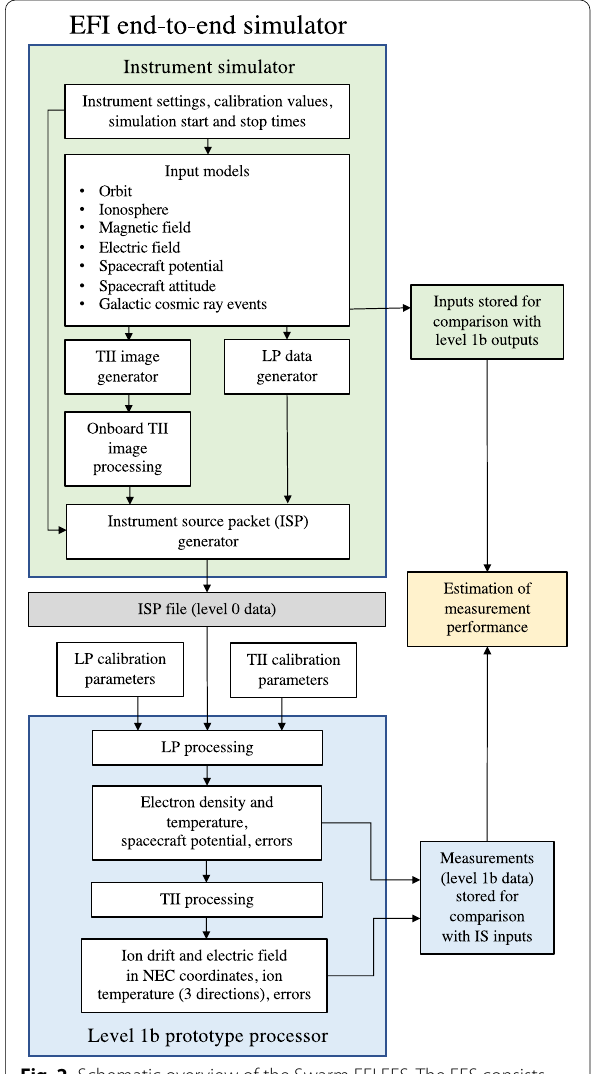
Fig. 2 Schematic overview of the Swarm EFI EES. The EES consists of the instrument simulator (top), the prototype level 1b processor (bottom), and an error estimation module